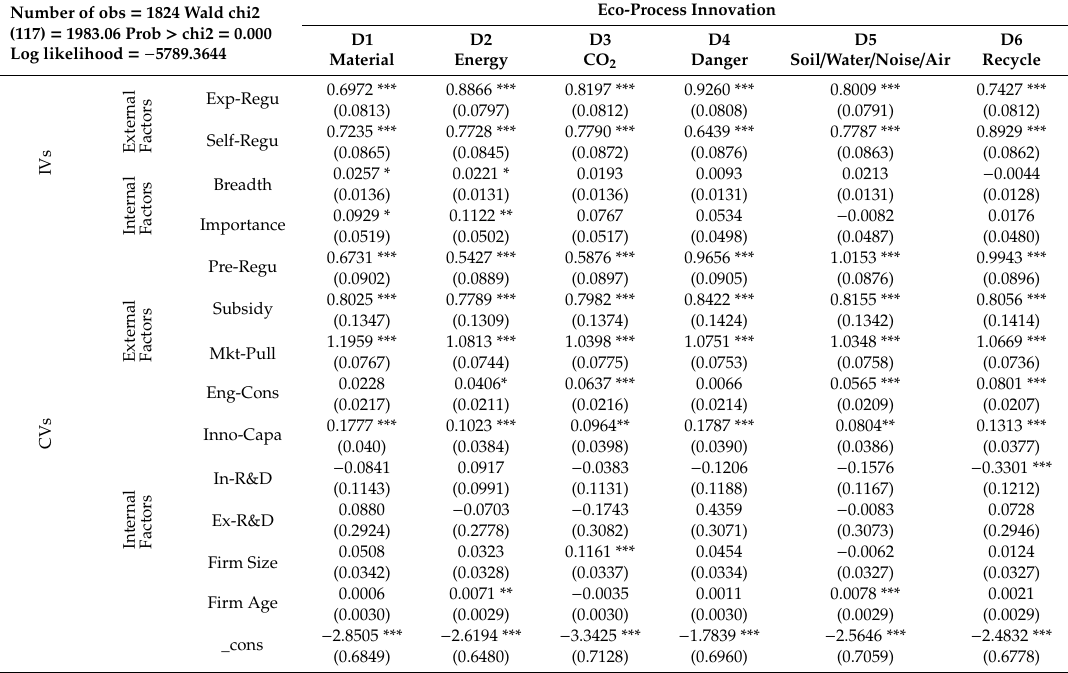
Table 4. ( a , b ) Drivers of Eco-Innovation by Di ff erent Types of Environmental Benefits. Number of obs = 1824 Wald chi2 (117) = 1983.06 Prob > chi2 = 0.000 Log likelihood = −